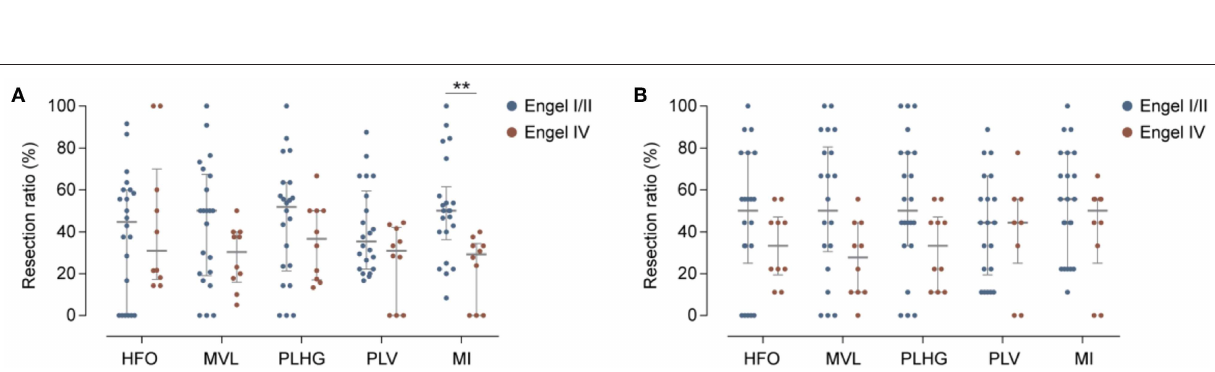
Frontiers in Neurology |